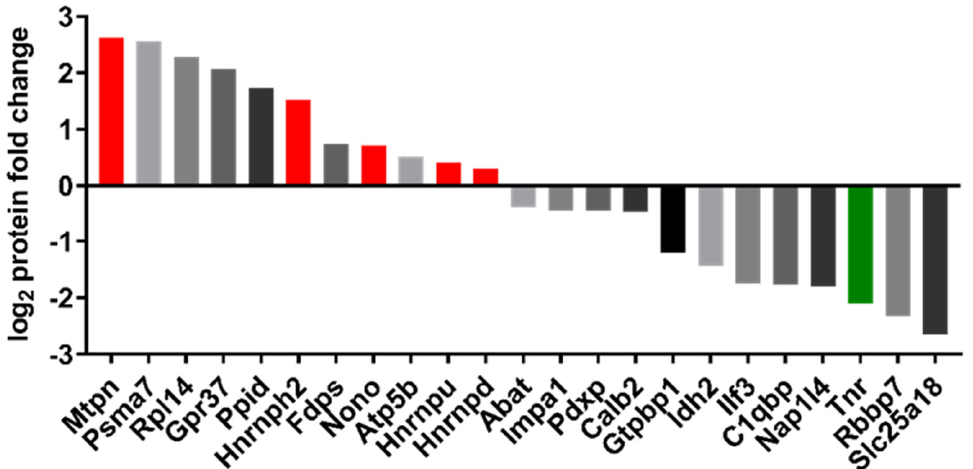
Figure 6. Illustration of the up- and downregulation of significantly altered protein expression identified by mass spectrometric analysis. Proteins were first isolated from the tissue after IOP elevation for proteomic analysis by mass spectrometry and then tryptically digested. The resulting peptides were purified for MS analysis. Peptides were identified, quantified, and normalized using MaxQant. For statistical analysis, a student’s t -test was used. The graph shows the upregulated and down-regulated proteins in the antibody-treated group compared with the control group. Of note were the three heterogeneous nuclear ribonucleoproteins that were upregulated and myotrophin (red). The extracellular matrix protein tenascin-R (Tnr), which was downregulated (green), also aroused great interest. The full names of the proteins are shown in Appendix A (Table A1).